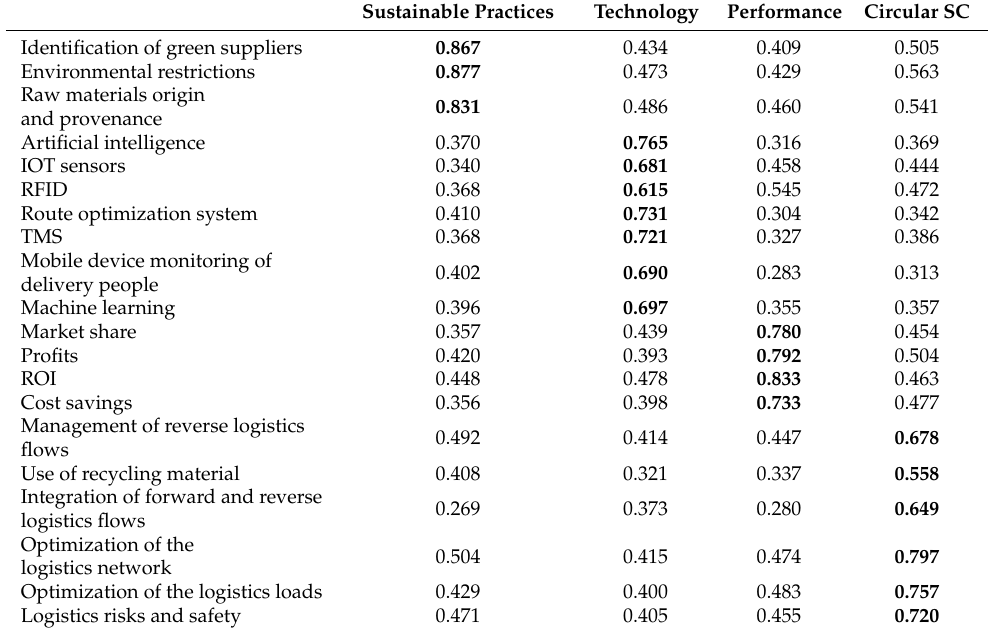
Table 2. Summary of the cross-loadings.